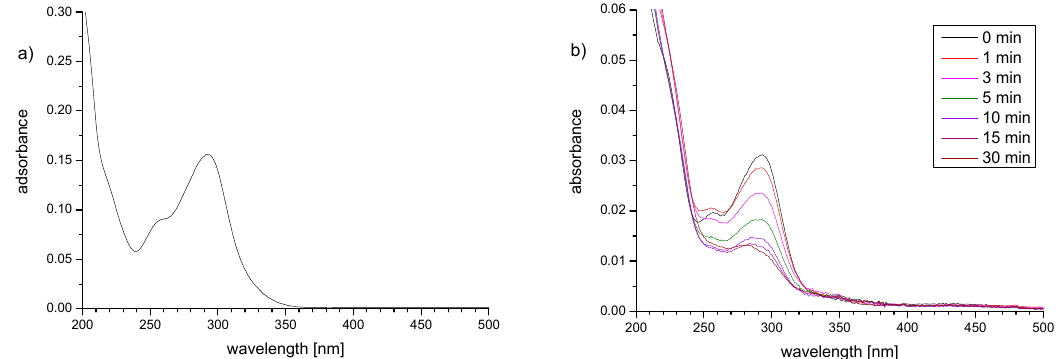
Figure 4. ( a ) UV-Vis spectra of photo-reactive monomer BPEMA in TFE solution (0.01 mM); ( b ) UV-Vis spectra of hydrogel films of P − x3a (P − xSPE) on a quartz support as function of the exposure-time to UV-irradiation (from top to bottom: 0, 1, 3,5, 10, 15, and 30 min).